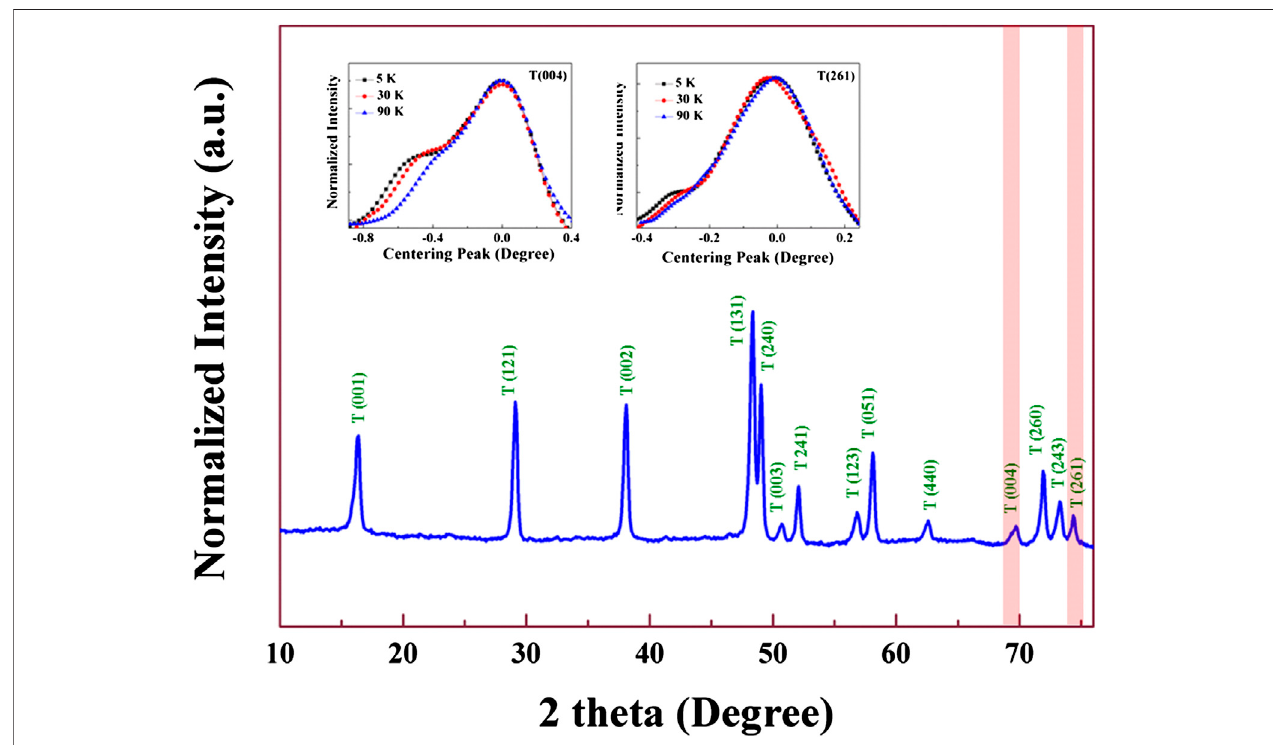
FIGURE4 | The neutron diffraction patternsofas-grown Fe 4 Se 5 nanosheet at 300 K.The tetragonal P4 symmetry isidenti fi ed. Theinsetsare thediffraction peaks of (004) and (261) at low temperatures showing the growth of additional peaks, indicating a structural change at low temperature.